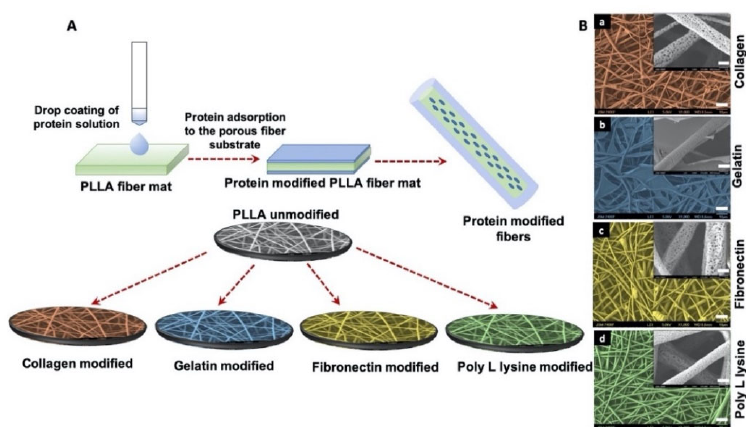
Figure 2. ( A ) Schematic illustration of protein functionalization on porous PLLA scaffolds. Simple drop coating of extracellular matrix (ECM) proteins to porous fiber surface was used for surface functionalization. ( B ) SEM micrographs of protein functionalized porous PLLA scaffolds (false color coded) (scale bar=10 μ m). The inserts are corresponding magnification of 5000× (scale bar=1 μ m). The magnified surface of fiber shows that pores of ( a ) PLLA collagen ( c ) PLLA Fibronectin ( d ) PLLA Poly L lysine are distinctively visible whereas ( b ) PLLA Gelatin fiber scaffold is covered with a layer of gelatin sheet.